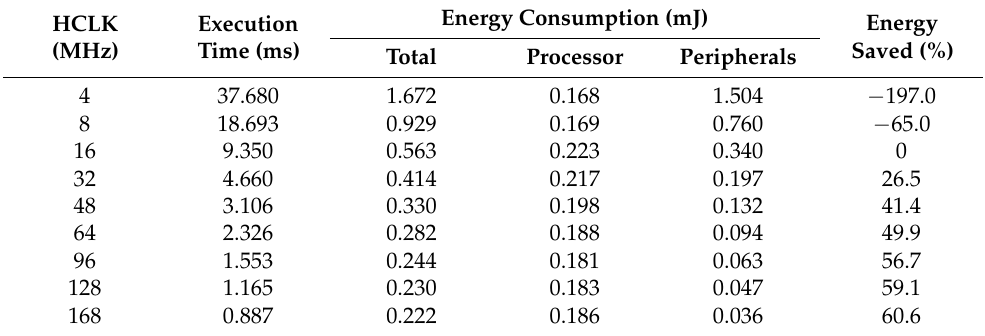
Table 1. Energy consumption of the whole system and peripherals at different processor clock frequencies.